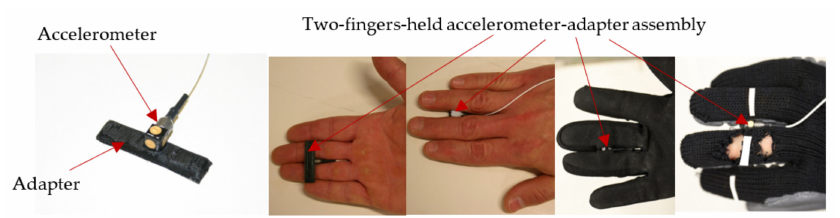
Figure 2. A two-fingers-held adapter for measuring the vibration input to the hand